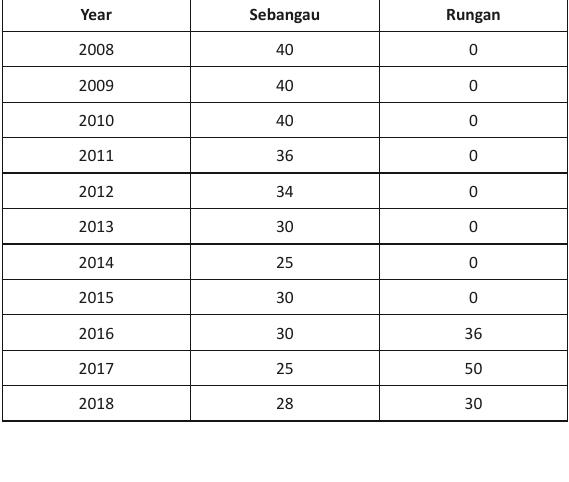
Table 2. Number of camera trap (CT) locations at each site (NA - habitat type not present in the study site).